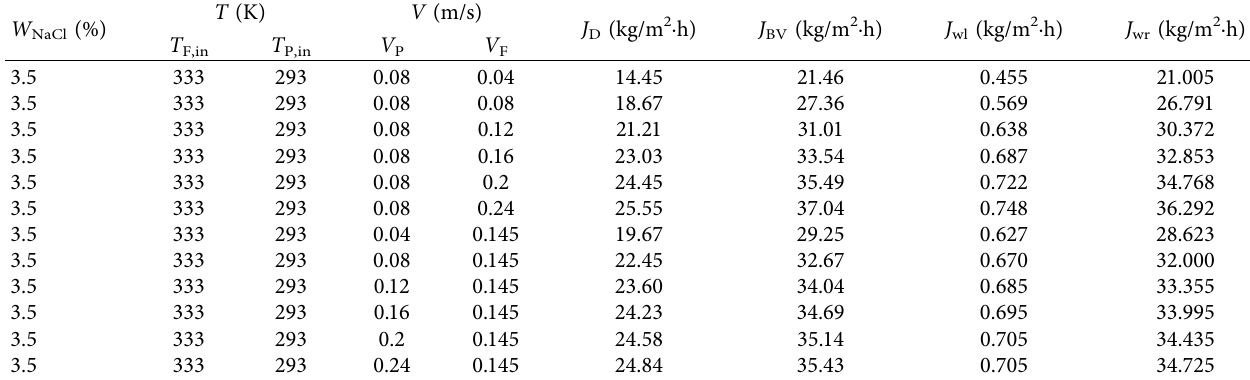
Table 3: Predicted water production rate of a BVDCMD seawater desalination